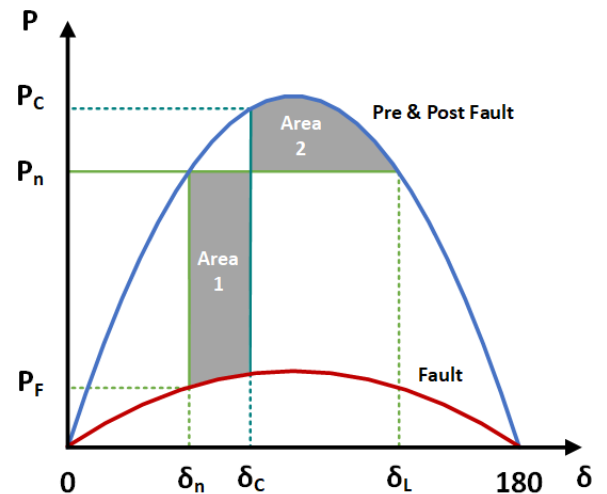
Figure 2. Power transmission capability of the normal system (blue curve) and the system with fault (red curve) [11].